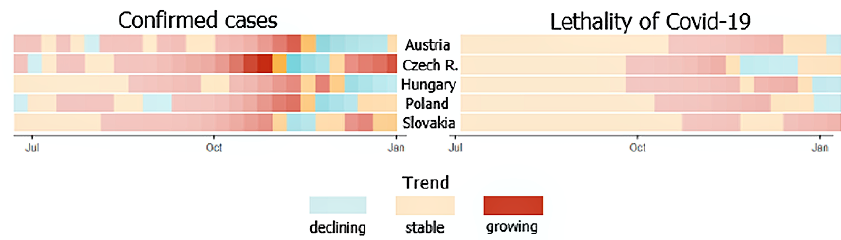
Figure 7. Developmental trends of 14-day confirmed cases and of